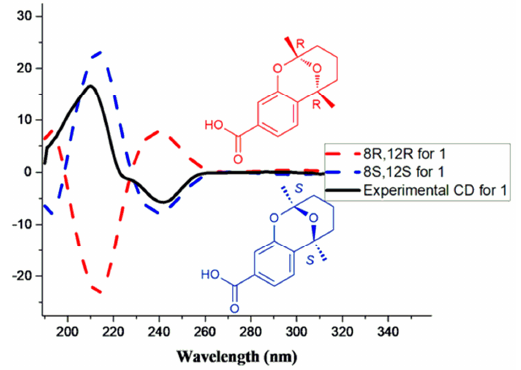
Figure 3. The calculated ECD and experimental CD spectra of compound 1 .